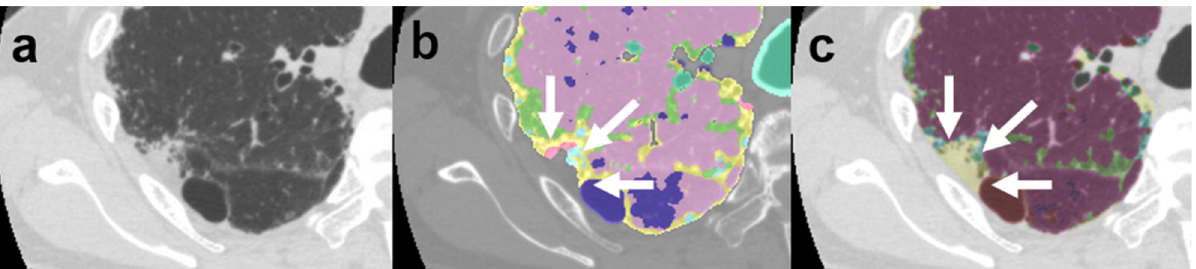
Figure 3. Images of a 72-year-old man with idiopathic pulmonary fibrosis. ( a ) Computed tomography image; ( b ) computer-aided diagnosis (CAD) method image; ( c ) deep-learning (DL)-based image. On the CAD method image ( b ), the pleuroparenchymal fibroelastosis (PPFE)-like lesion in the peripheral area (white arrow) was neglected because it was considered extrapulmonary. On the DL-based analysis image ( c ), the PPFE-like lesion (white arrow) is accurately classified as consolidation (CF DL ). The color code follows that described in the legend of Figure 2.